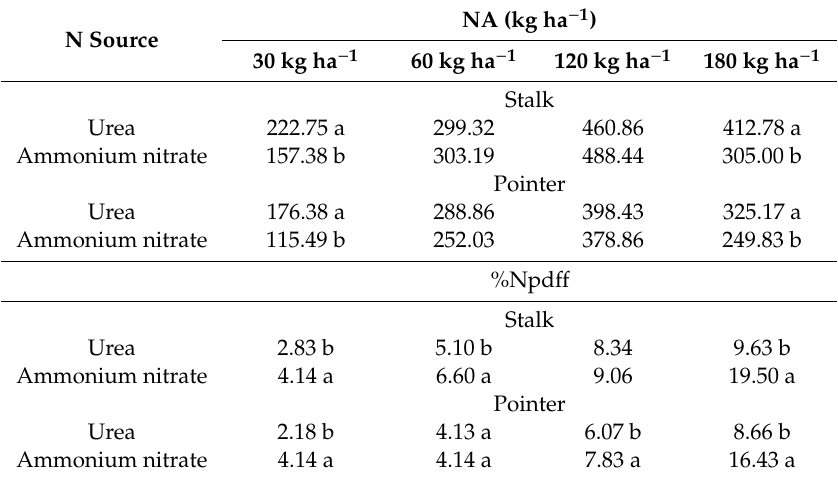
Table 2. Nitrogen accumulated (NA) and percentage of N in sugarcane plant derived from fertilizer (%Npd ff ), by sugarcane plant (stalk and pointer), in the cane plant cycle, as a ff ected by N rate as ammonium nitrate and